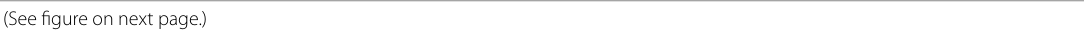
Fig. 14 The same as Fig. 4, but for the Swarm residuals � X ( 2 ) sm (thin black), � Y ( 2 ) sm (thin green) and � Z ( 2 ) (thin orange) that are corrected for the magnetic fields of PEJs and FACs and grouped in discrete time bins of 1-h duration before the adjustment by the two-circular loop model of MRCs and MICs. The resulting MMF, denoted as MMC ( 2 ) , revises the first-order estimate of MMF, denoted as MMC ( 1 ) , for which determination no corrections due to PEJs and FACs have been applied. Vertical dashed violet lines denote the mid-latitude interval I 10 ◦